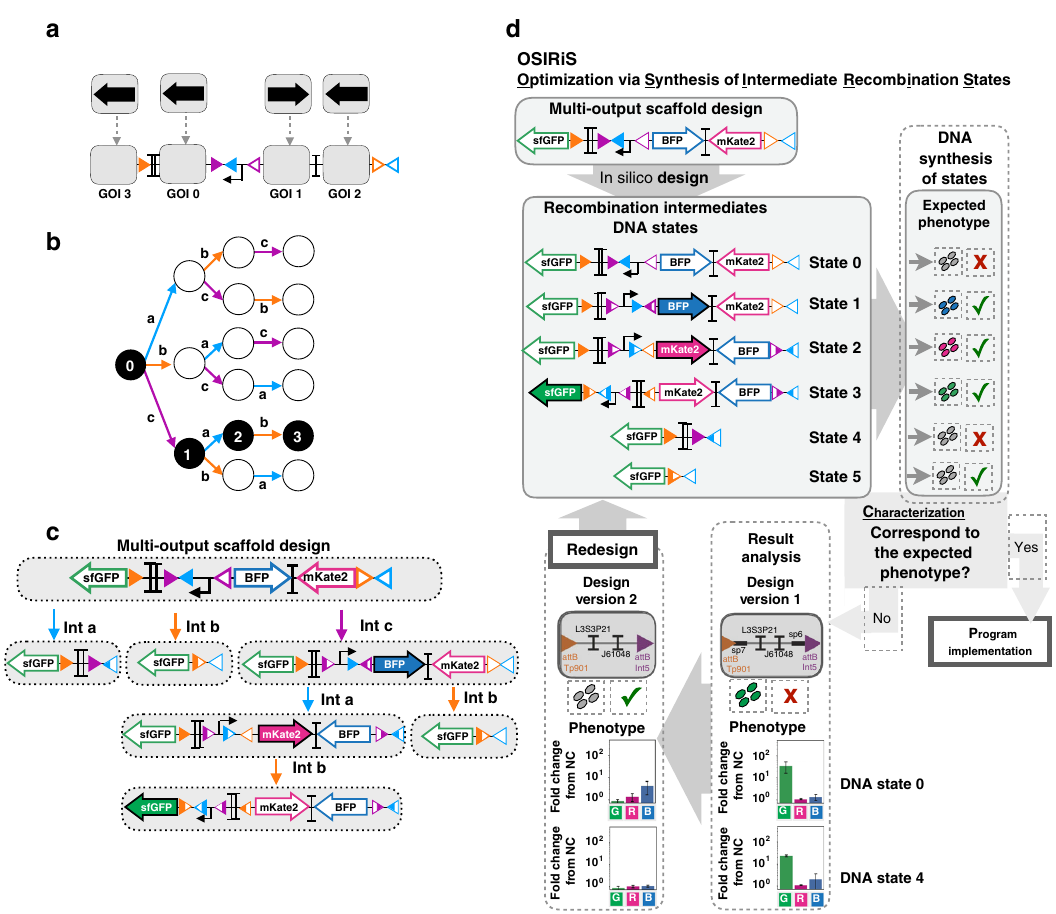
Fig. 4 Design of a modular scaffold for 3-input history-dependent programs. 3-input history-dependent scaffold ( a ) and its lineage tree ( b ). Integrase sites are positioned to permit expression of an output gene in various states of the lineage tree. For each state of the desired lineage, a different gene is expressed, and a gene is also expressed when no input is present. The four columns of the lineage tree correspond to different numbers of inputs that have occurred sequentially (from 0 to 3 inputs) and the six lineages correspond to different order of occurrences of inputs (example: a – b – c for lineage 1 and b – a – c for lineage 3). c DNA and gene-expression states of the scaffold. The gene at the GOI position 0 is expressed only when no input is present. The scaffold has six different DNA states. d Optimization of the 3-input scaffold using OSIRiS. For a given 3-input program, a scaffold with consecutive expressions of BFP, RFP, and GFP in one lineage is designed. From this design, six intermediate DNA states are generated and the expected phenotype for each DNA state of the tree is predicted. Two versions of this 3-input scaffold were analyzed. Version 1 was producing unexpected GFP fl uorescence in state 0 and state 4. Version 2 is an optimized design from version 1, in which two DNA sequences corresponding to spacers sp7 and sp6, fl anking L3S2P21 and J61048 terminators, were removed. The fl uorescence intensities in different channels for two versions in DNA states 0 and 4 is shown. The bar graph corresponds to the fold change over the negative control (strain without fl uorescent protein) for each channel (GFP, RFP, and BFP) from three experiments with three replicates per experiment. The error bars correspond to the standard deviation between the fold changes obtained in three separate